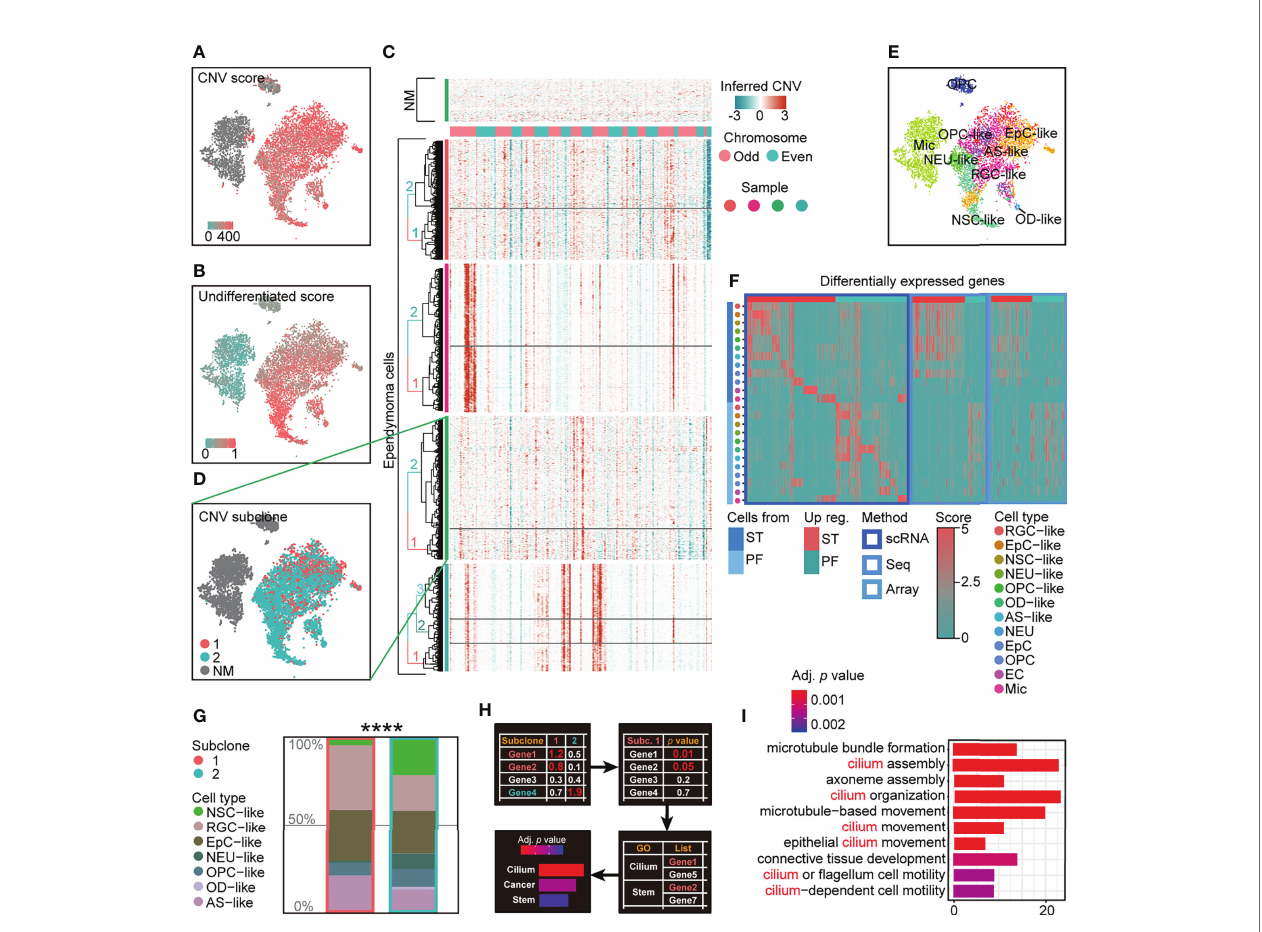
FIGURE 1 | scRNA-seq analysis reveals intratumoral subclone heterogeneity in PF-EPN. (A) CNV score calculated by modi fi ed inferCNV of PF-EPN sample GTE009 presented on tSNE reduction. (B) Undifferentiated score calculated by CytoTRACE of PF-EPN sample GTE009 presented on tSNE reduction. (C) CNV heatmap (rows represent cells, and columns represent CNV score of genes) of malignant tumor cells from four EPN samples labeled by genetic subclone information for each sample. (D) Subclonal populations in malignant cells and NM cells of PF-EPN sample GTE009 classi fi ed by CNV pattern presented on tSNE reduction. (E) tSNE plot of all clusters in PF-EPN sample GTE009 color coded by cell types with unbiased visualization by SCUBI (12). (F) Heatmap of DEGs calculated by cell types and pathogenic sites from scRNA-seq data in this study and bulk-DEGs. Aforementioned bulk-DEGs were calculated by pathogenic sites from online bulk-seq data [Gene Expression Omnibus (13, 14); Seq: GSE89448 (15); Array: GSE64415 (1, 16, 17); aligned to human reference genome GRCh38(hg38)] through DESeq2 (18). (G) Histogram of cell types in PF-EPN sample GTE009 colored by cell types in percentage and outlined by subclone annotation showing signi fi cant difference ( p value = 7.975e − 05) in cell-type proportions using asymptotic two-sample Fisher – Pitman permutation test. (H) Work fl ow of gene ontology enrichment analysis comparison between PF-EPN sample GTE009 subclones 1 and 2. (I) Gene ontology analysis of upregulated genes in the PF-EPN sample GTE009 subclone 1 compared to the subclone 2 ordered by adjusted p -value. The "*" means signi fi cant difference (p-value): * p < 0.05; ** P < 0.01; *** p < 0.001; **** p <